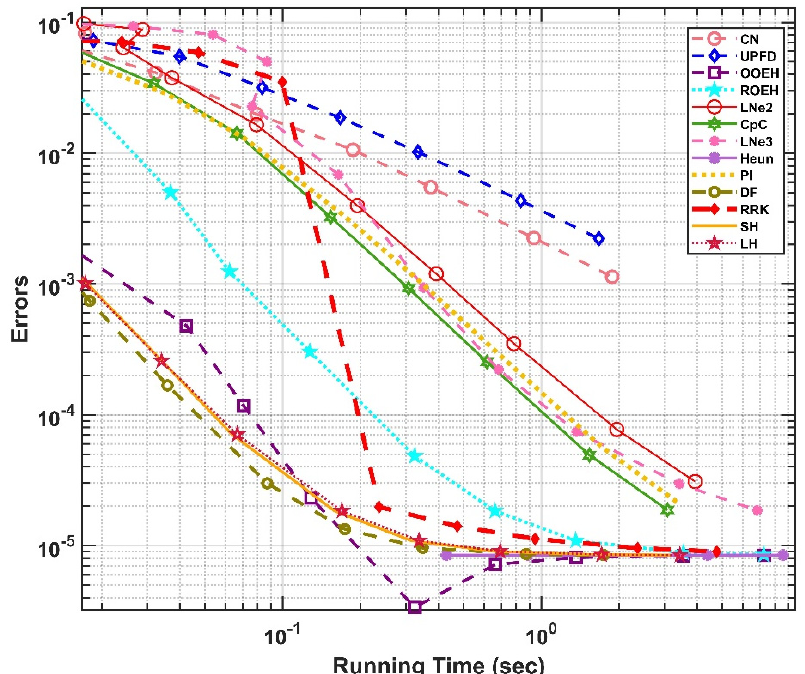
Figure 7. The maximum errors as a function of the running time for the 13 examined methods in the case of an equidistant mesh.